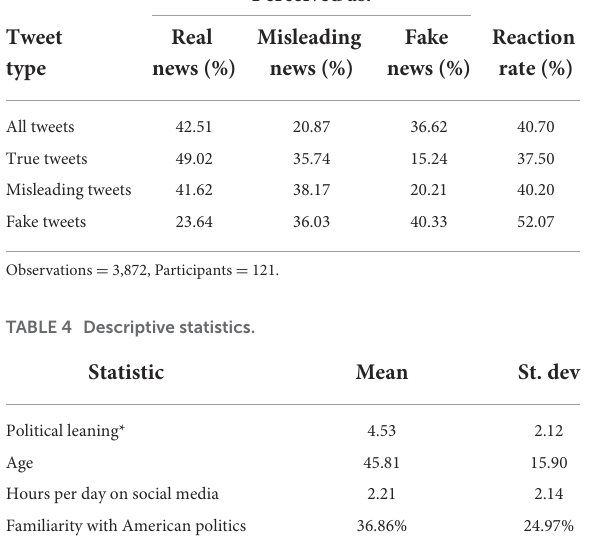
TABLE 3 Tweet perception and reaction